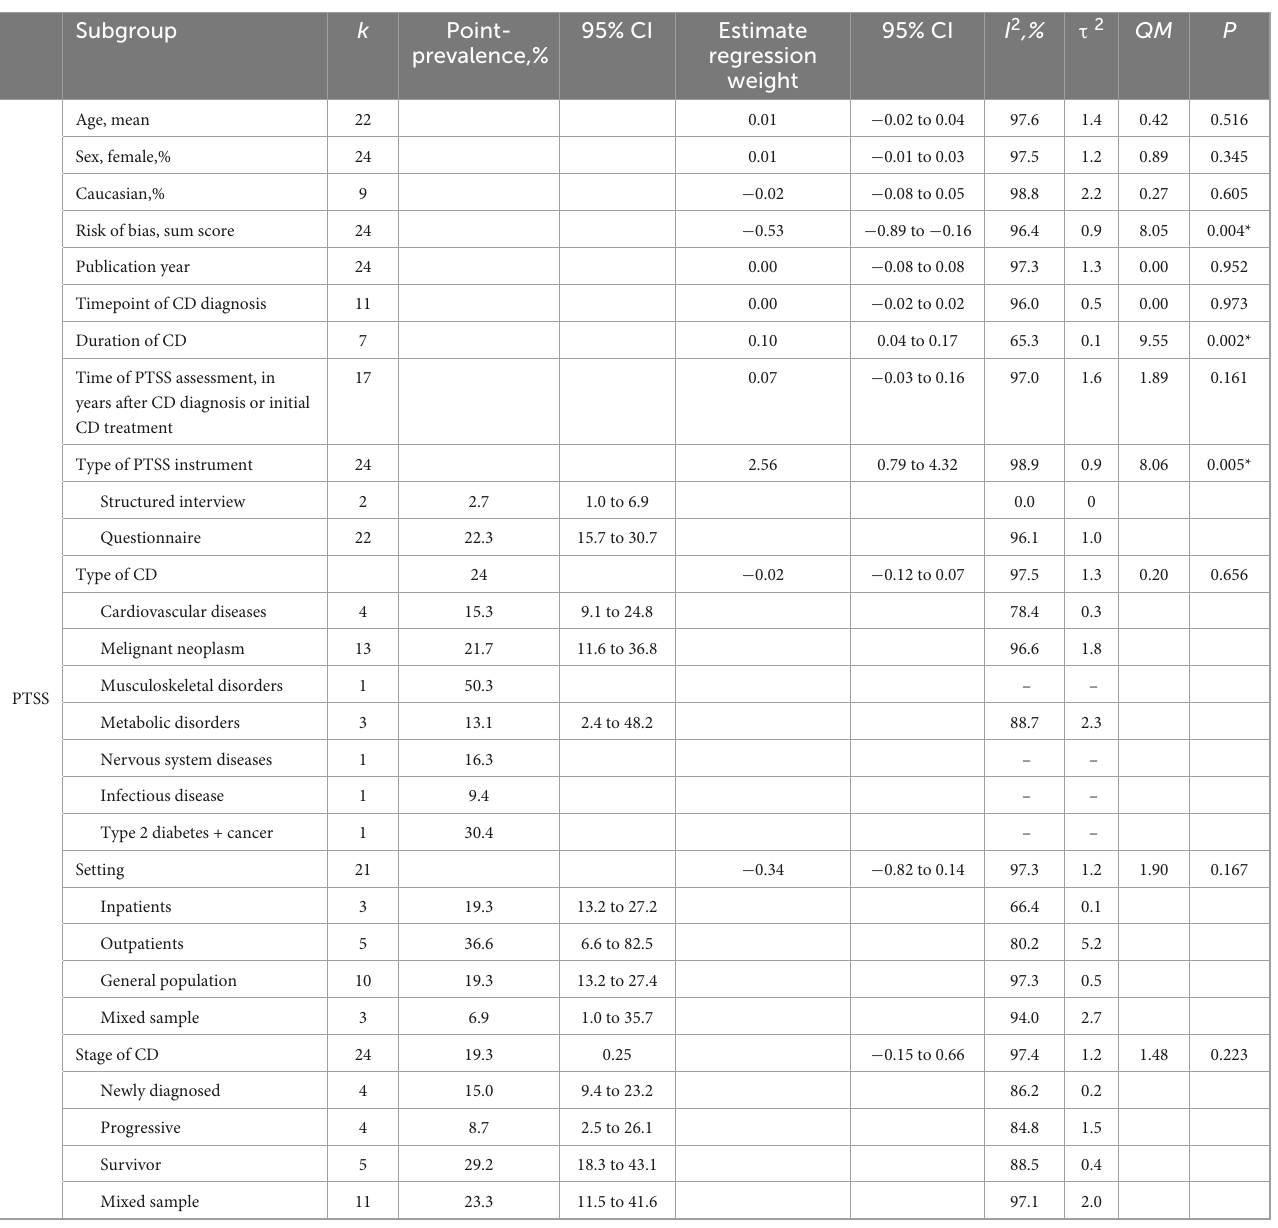
TABLE 2 Meta-regressions of point prevalence of PTSS in people with CD.